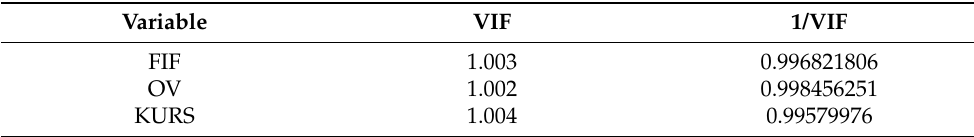
Table 10. Multicollinearity Test.